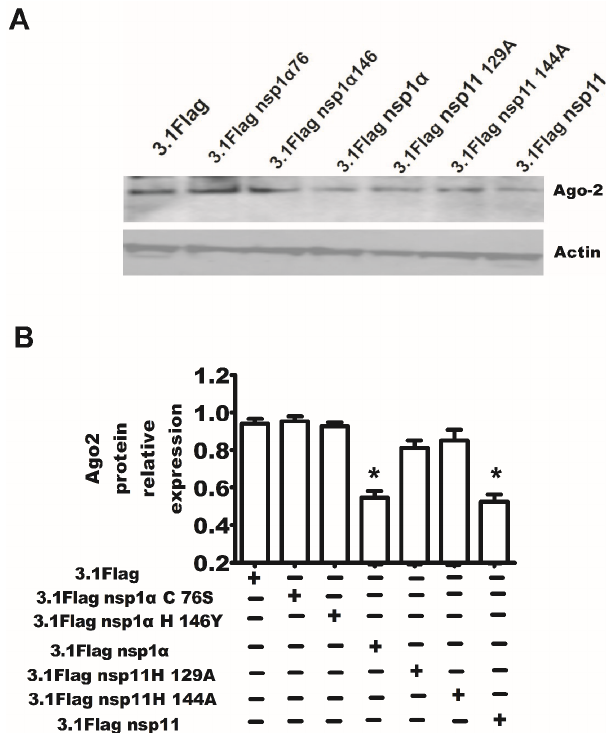
Figure 6. The papain-like cysteine proteinase activity of nsp1 α and the activity of endoribonuclease of nsp11 were essential for them to downregulate the Ago-2 protein. ( A ) MARC-145 cells were transfected with the expression plasmid of nsp1 α , nsp1 α C76S, nsp1 α H146A, nsp11, nsp11 H129A, nsp11H144A or control plasmid pcDNA 3.1-Flag. Additionally, after 48 h, the cells were ready for Western blotting. The Western blot results were quantified by Quantity One Software ( B ). The results are from one of three independent experiments with similar observations. * p <